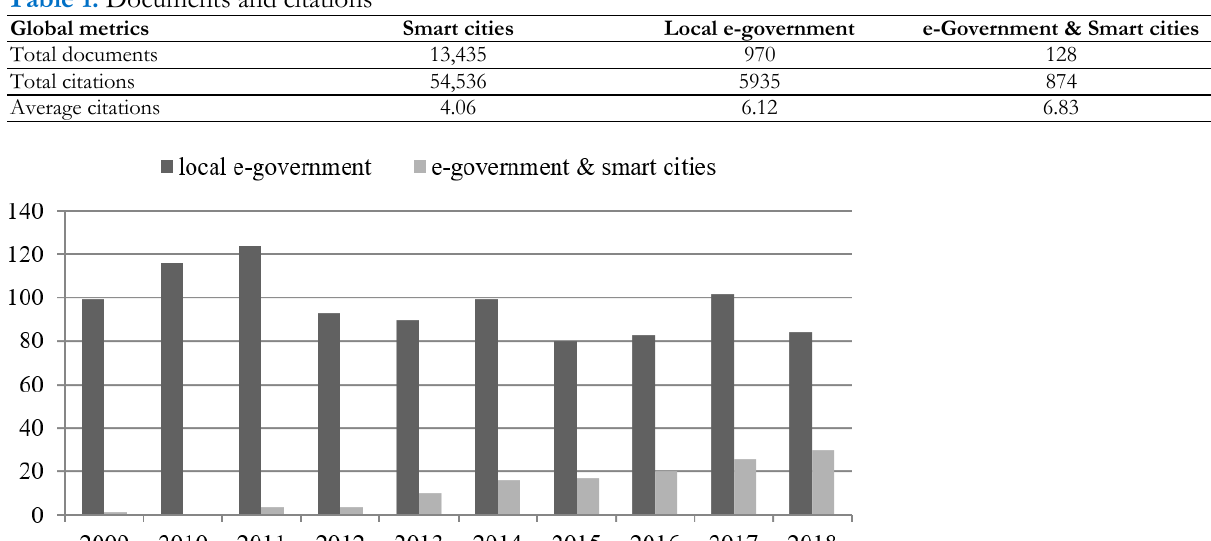
Figure 2. Evolution of the number of research documents addressing local e-government (excluding smart cities) and of documents addressing smart cities in the context of e-government, published between 2009 and 2018, as retrieved from the Scopus